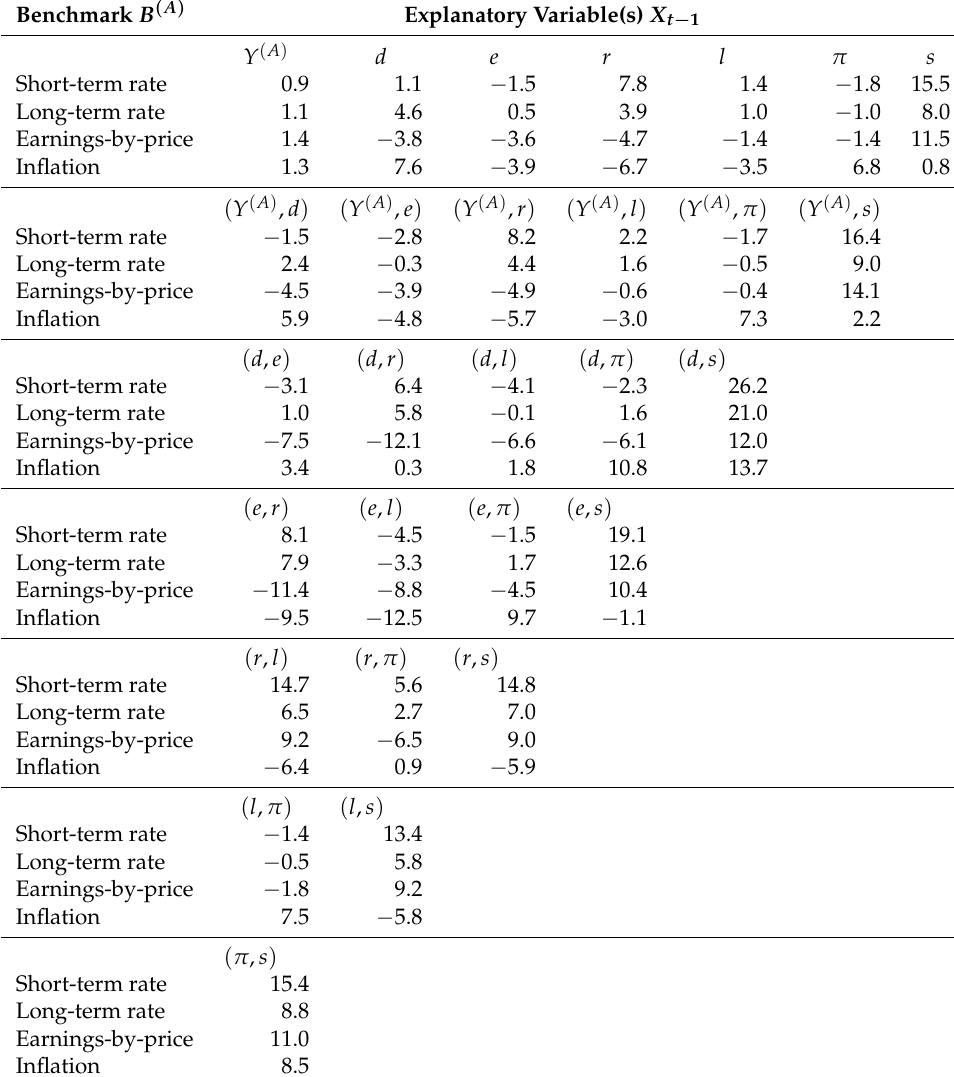
Table 3. Predictive power measured by R 2 benchmarking